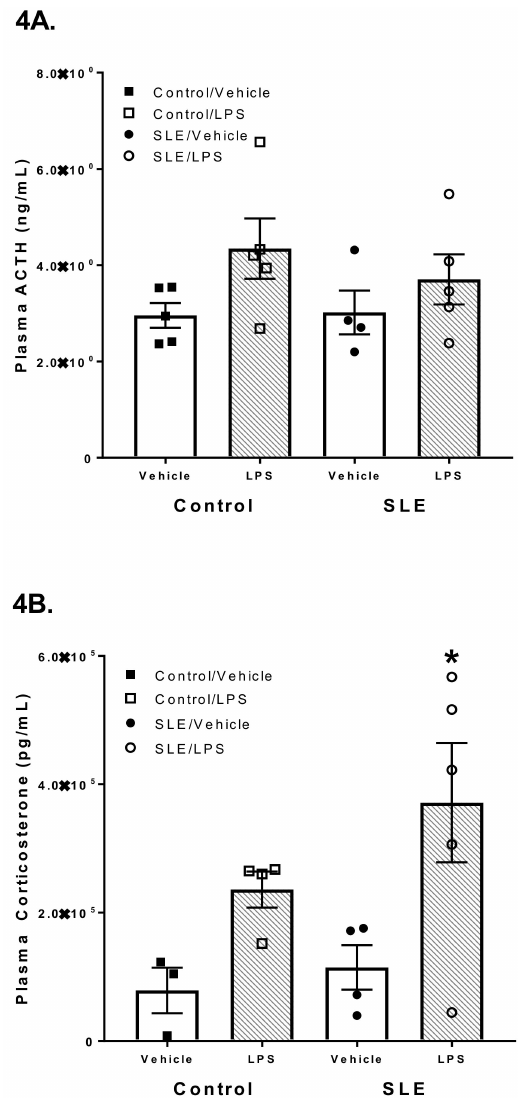
Figure 4. ( A ) Lipopolysaccharide (LPS) challenge does not affect plasma adrenocorticotrophic hormone (ACTH) concentration in systemic lupus erythematosus (SLE) and control mice. ( B ) LPS challenge provokes a significant increase in plasma corticosterone in SLE mice. All values are reported as mean ± SEM, and the results of the two-way ANOVA indicated a significant difference between LPS-challenged SLE mice and their n counterparts. * p SLE/LPS vs. SLE/Vehicle. Plasma corticosterone was not different in SLE mice compared to C57 mice (1.1 × 10 5 ± 3.5 × 10 4 vs. 4.7 × 10 4 ± 2.0 × 10 4 ; p = 0.348, data not shown). Similarly, plasma corticosterone was not different in SLE mice compared to NZW controls (1.1 × 10 5 ± 3.5 × 10 4 vs. 7.9 × 10 4 ± 3.6 × 10 4 ; p = 0.613; Figure 4B) LPS-challenged SLE mice had increased plasma corticosterone compared to vehicle-treated SLE mice (3.7 × 10 5 ± 9.3 × 10 4 vs. 1.1 × 10 5 ± 3.5 × 10 4 ; p = 0.009). By contrast, plasma corticosterone was not significantly altered in LPS-challenged control mice compared to their vehicle-treated counterparts (2.4 × 10 5 ± 2.8 × 10 4 vs. 7.9 × 10 4 ± 3.6 × 10 4 ; p = 0.152; Figure 4B).